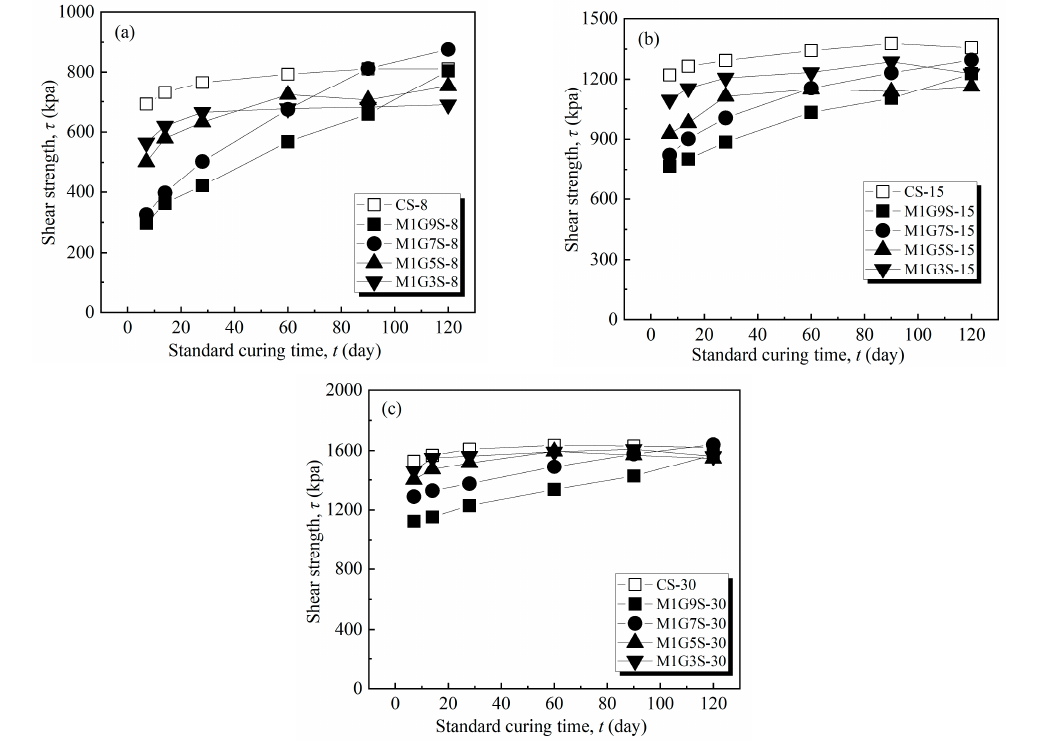
Figure 6. Variations of shear strength ( τ ) with different ratios of binder on ( a ) 8%, ( b ) 15%, and ( c ) 30%.